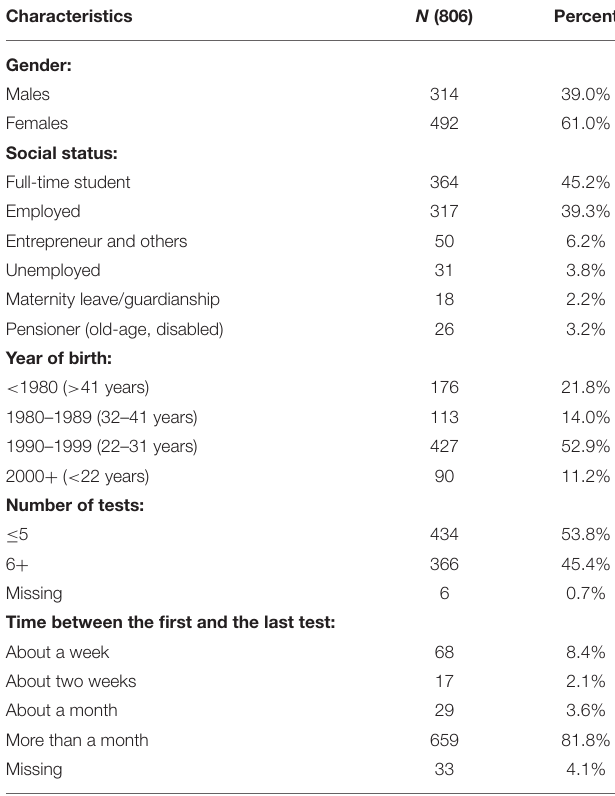
TABLE 1 | Descriptive profile of the research